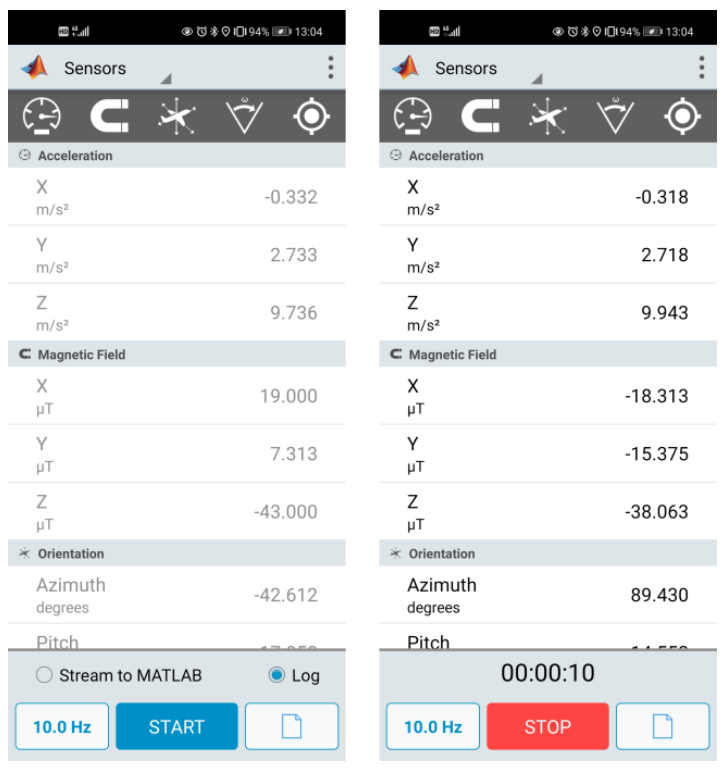
Figure 3. The process of getting data from